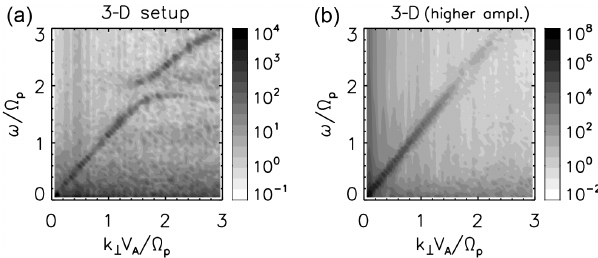
Figure 5. Wavenumber–frequency spectrum for magnetic field fluc- tuations in 3-D plasma simulations at a time of 500 ion gyro- periods. (a) and (b) display slices along the k ⊥ 1 axis obtained from using lower and higher amplitudes of the initial pumping